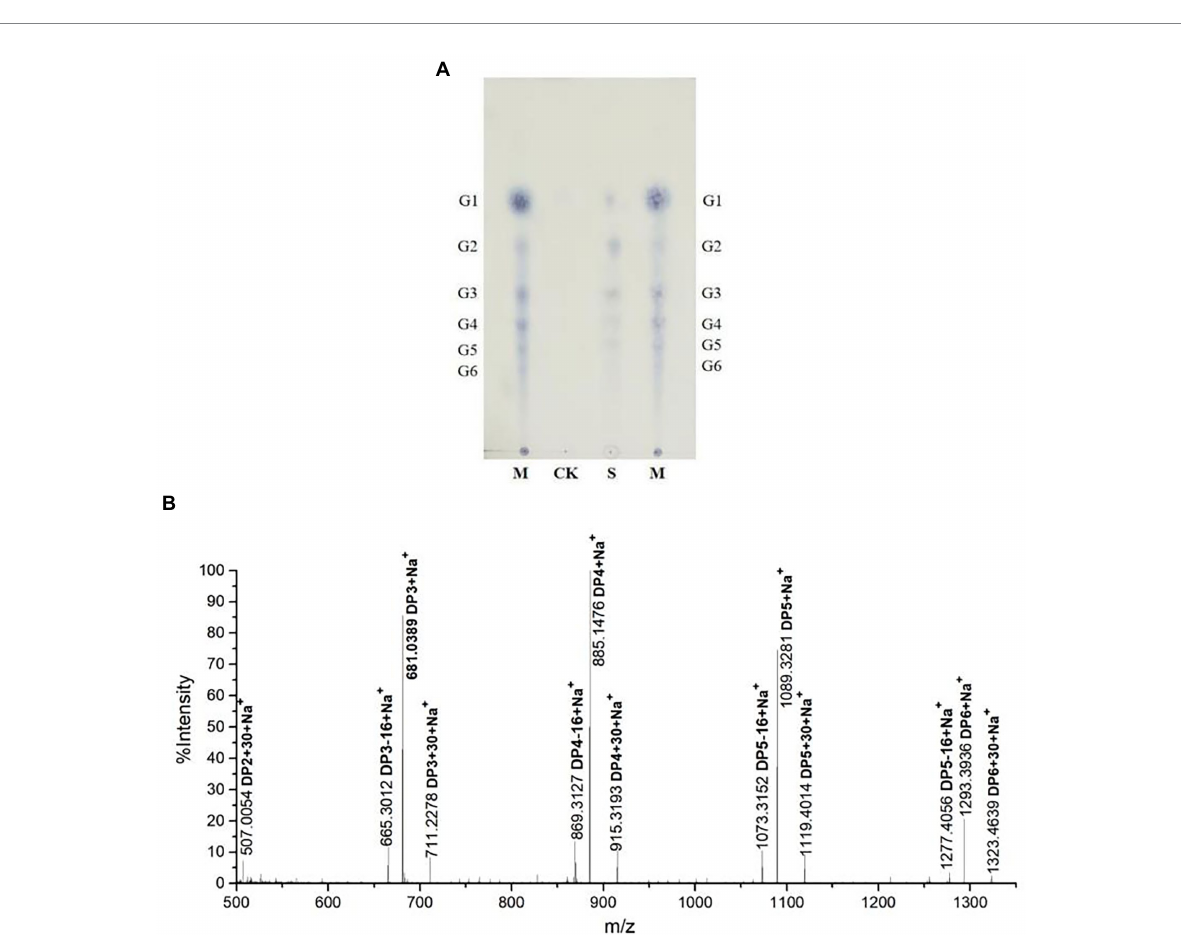
FIGURE 4 Analysis of rTaAA9A reaction products. (A) Analysis of rTaAA9A reaction products by TLC method. M, standard cellulosic oligosaccharides (G1–G6); S, rTaAA9A reaction products; CK, control sample was analyzed as above, except that rTaAA9A was not added. (B) Identification of the